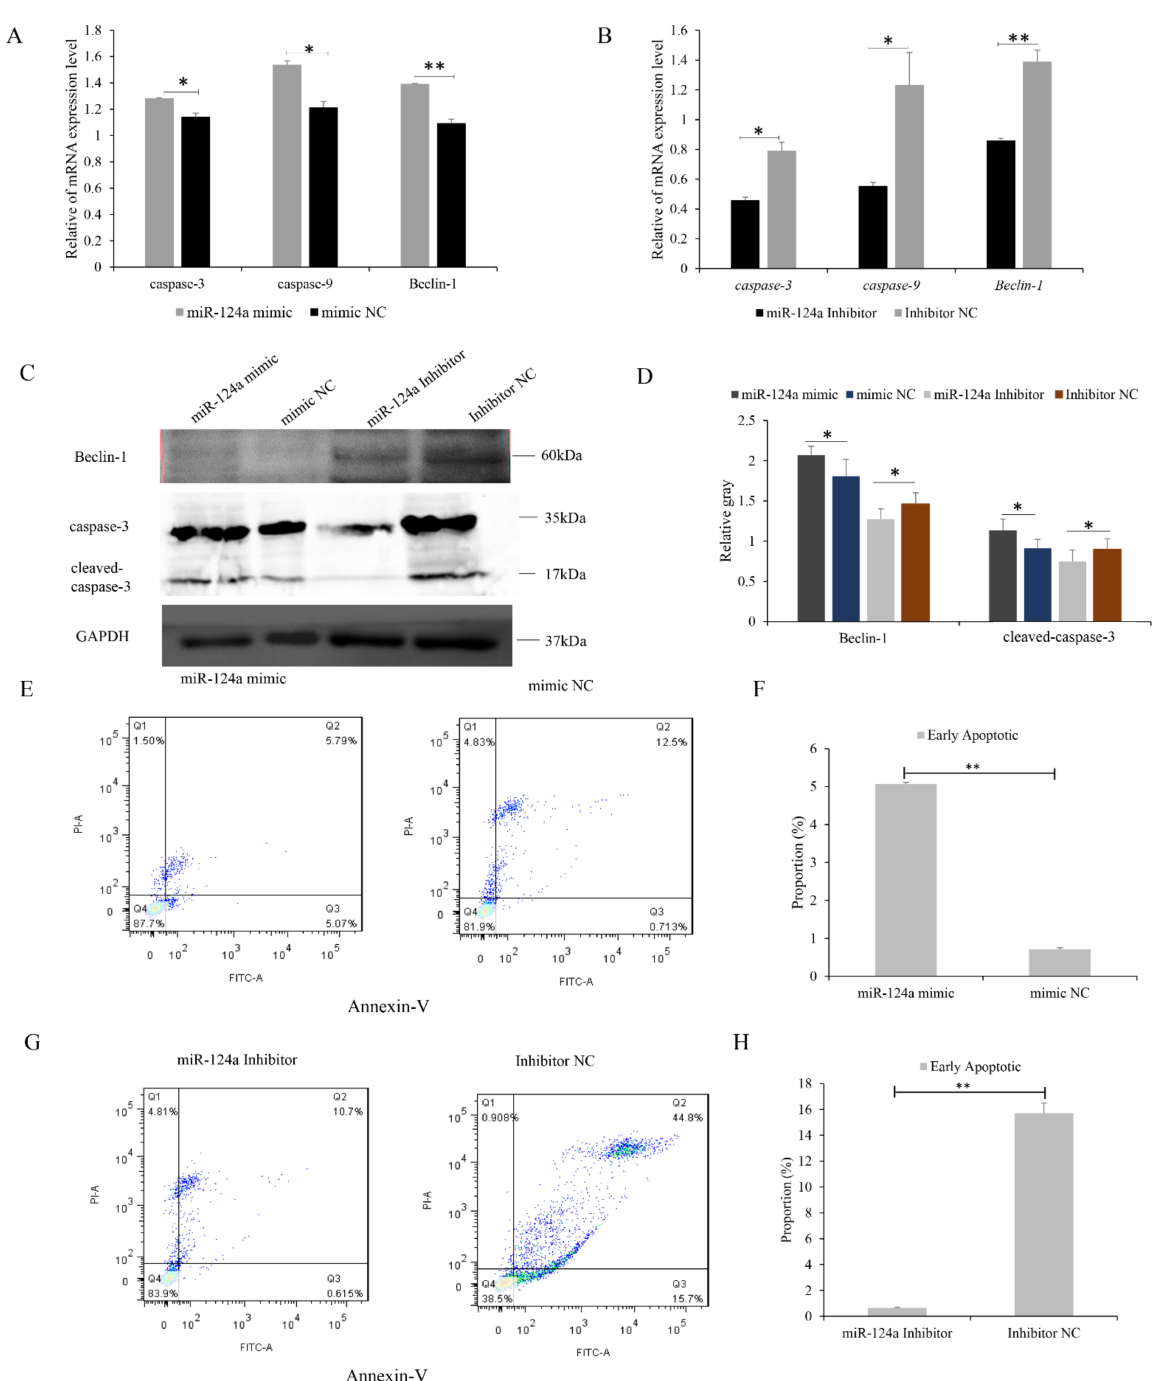
Figure 7. miR-124a regulates apoptosis of goat myoblasts: ( A , B ) Expression levels of cell-apoptosis- related genes (caspase-3, caspase-9, and beclin-1) in cells overexpressing and underexpressing miR- 124a were quantified by RT-qPCR. ( C , D ) Western blot analysis revealed the expression of caspase-3 and beclin-1 after gain and loss of miR-124a. GAPDH was used as an internal reference. ( E ) My- oblasts overexpressing miR-124a were stained with annexin V–FITC/propidium iodide (PI), and then subjected to flow cytometry. ( F ) The percentage of miR-124a-overexpressing myoblasts in apoptosis. ( G ) Flow cytometry of myoblasts underexpressing miR-124a. ( H ) Percentage of miR- 124a-underexpressing myoblasts in apoptosis. Replicates = 3. Data are presented as the mean ± SE; * p < 0.05 and ** p < 0.01. NC, negative